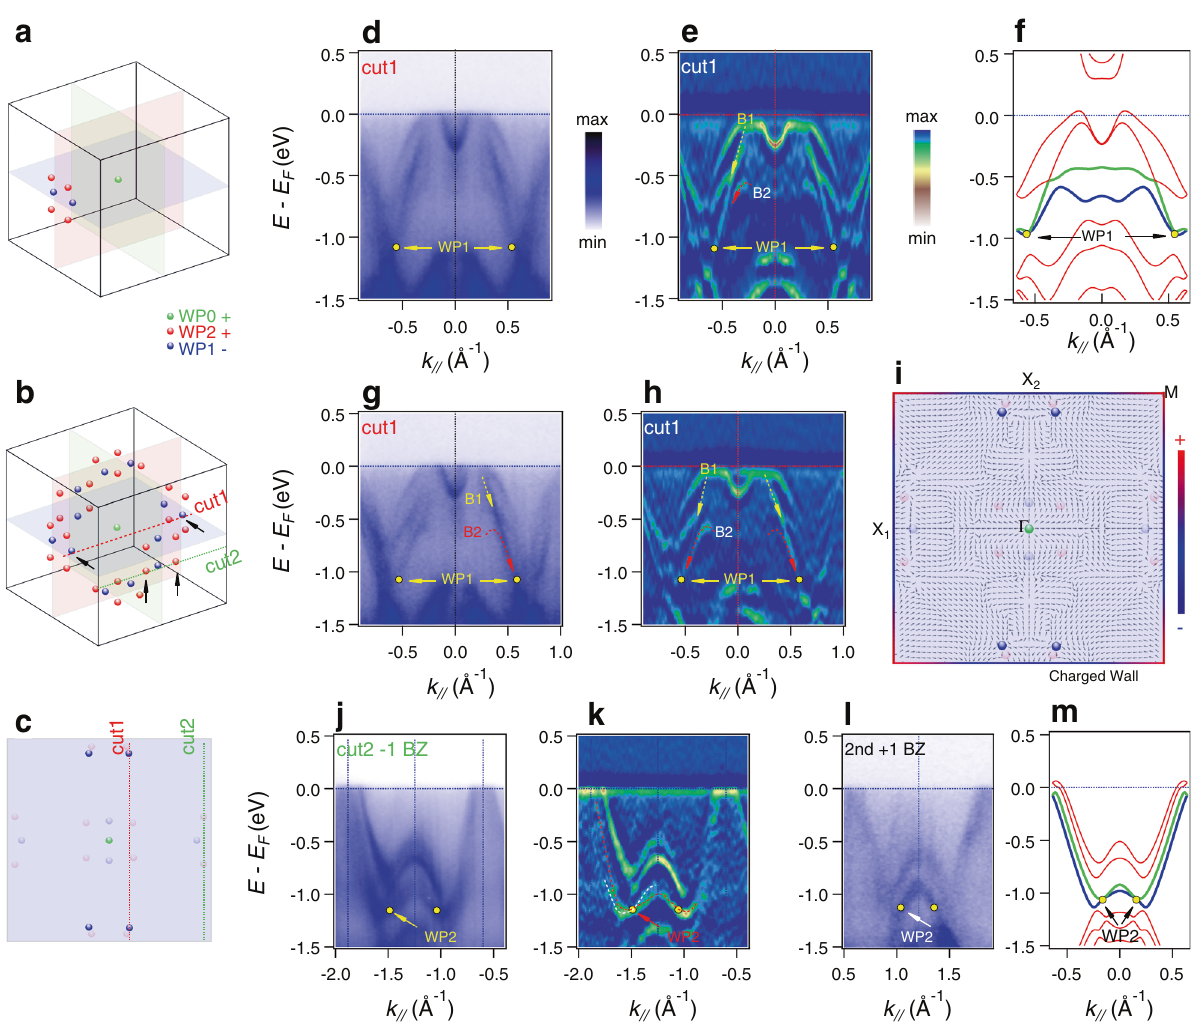
Fig. 4 Unpaired WPs at generic k points in PtGa. a , b A group of 6 WPs and their symmetrically equivalent WPs in the k -space, respectively. In addition, there is one WP at the center that is discussed in Fig.2, WP0 (green point), with chiral charge + 1. There are 12 unpaired accidental WP1 points (blue points) with chiral charge − 1 and 24 unpaired accidental WP2 points (red points) with chiral charge + 1. The net chiral charge of the WPs in a BZ is + 13. c Projections of the WPs along the (001), (010), or (100) direction. The WPs marked with opaque (semitransparent) colors are located in (out of) the Γ – X – M plane perpendicular to the projection direction. d , e Symmetrized ARPES spectrum along cut1 (in b , c ) across two WP1 and its curvature intensity plot, respectively. The arrows indicate the WP1 points. f Calculated band structure along cut1. g , h Raw ARPES spectra along cut1 and its curvature intensity plot, respectively. i In-plane component of the Berry curvature fi eld in the k z = 0 plane with the projections of the WPs overlaid on top. The colors on the BZ boundaries show the distribution of the topological charge on WNWs. j , k The ARPES spectrum along cut2 (in b , c ) across two WP2 points and its curvature intensity plot, respectively. l The ARPES spectrum along the cut2 in the second BZ. m Calculated band structure along state. Thus, the spin polarization of bands N − 2 and N − 3 provide additional essential evidence for the existence of the singular WP.